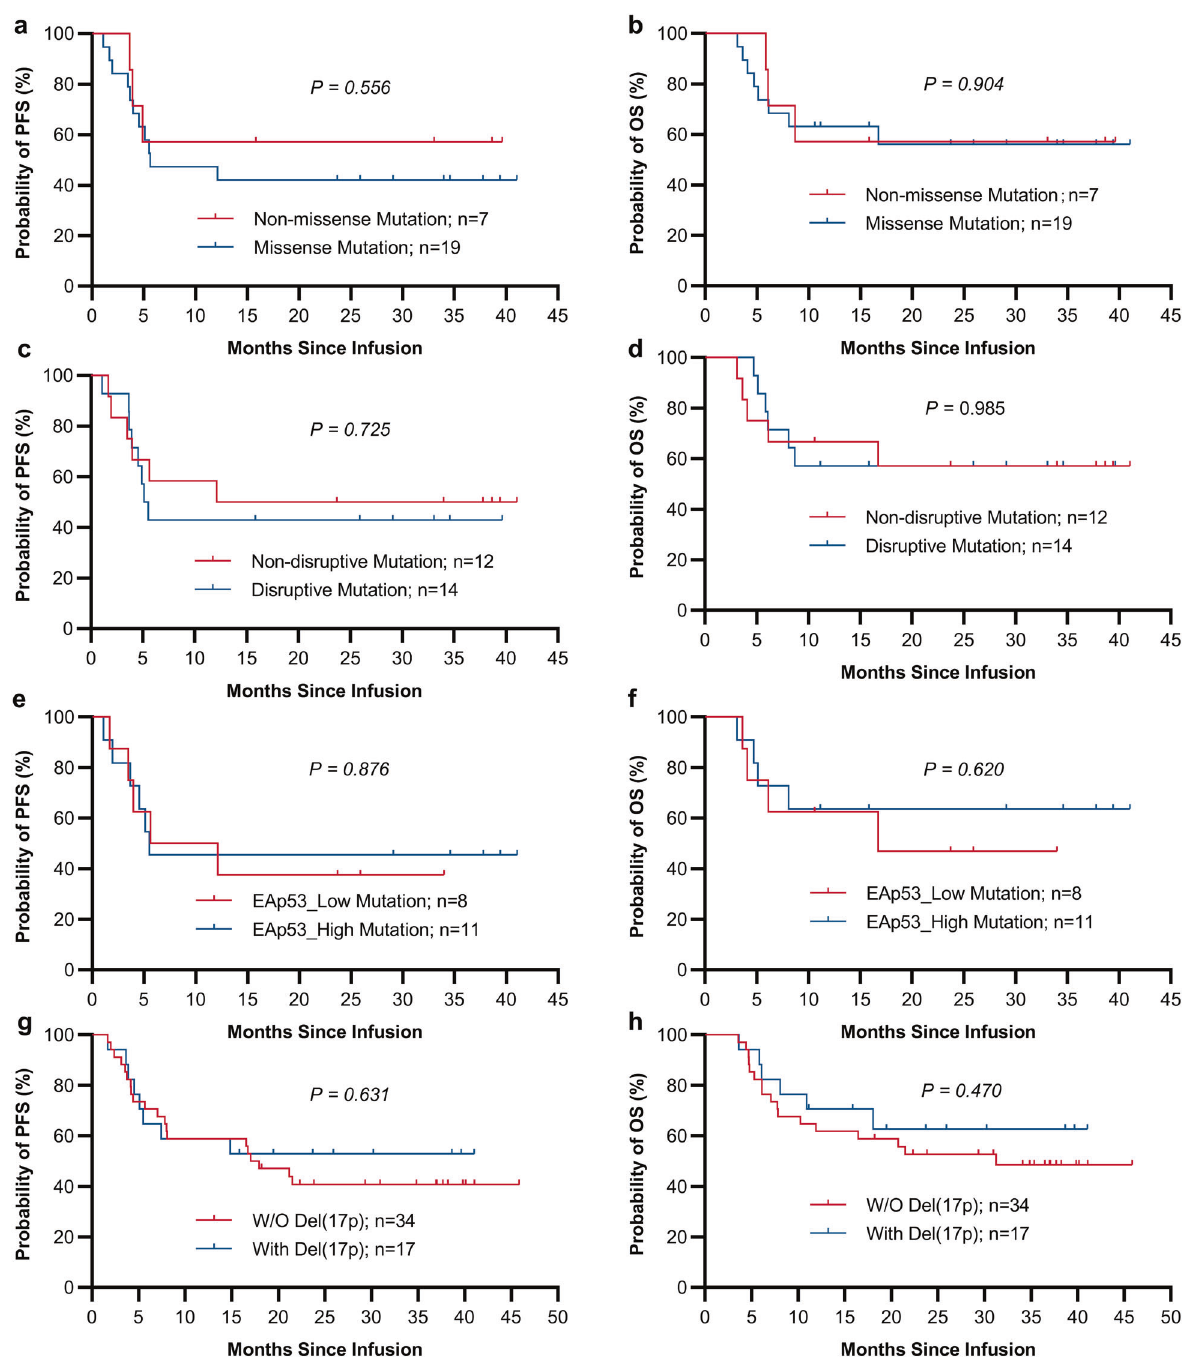
Fig. 3 Outcomes of r/r aggressive B-cell cases strati fi ed by four functional classi fi cation systems of TP53 alterations after CAR19/22 T-cell infusion. In individuals with r/r aggressive B-cell lymphoma and concurrent TP53 mutations, PFS ( a , c and e ) and OS ( b , d , and f ) were compared according to functional classi fi cations of TP53 mutations. Kaplan – Meier analysis of PFS ( a ) and OS ( b ) for the non-missense and missense mutation groups. Kaplan – Meier analysis of PFS ( c ) and OS ( d ) for the non-disruptive and disruptive mutation groups. Kaplan – Meier analysis of PFS ( e ) and OS ( f ) for EAp53 low-risk (<75) and EAp53 high-risk ( ≥ 75) mutation groups. Kaplan – Meier analysis of PFS ( g ) and OS ( h ) in the del(17p) and non-del(17p) groups BELINDA, and TRANSFORM, are actively assessing whether CAR CAR T-cell infusion nowadays is becoming the preferred T-cell therapy could replace salvage HDT/ASCT as second-line curative option for chemo-refractory or ASCT ineligible patients, treatment in r/r LBCL. Interim analysis of the TRANSFORM study or cases that relapse after ASCT. The ZUMA-1, JULIET and showed the superiority of lisocabtagene maraleucel (Liso-cel) over TRANSCEND trials indicated ORRs of 41 – 83% in chemo-refractory HDT/ASCT in event-free survival, PFS and CR rate, supporting the patients and ORRs of 53 – 76% in those with relapse within the fi rst potential administration of Liso-cel in earlier lines of therapy in year post-ASCT. Moreover, several clinical trials, including ZUMA-7,